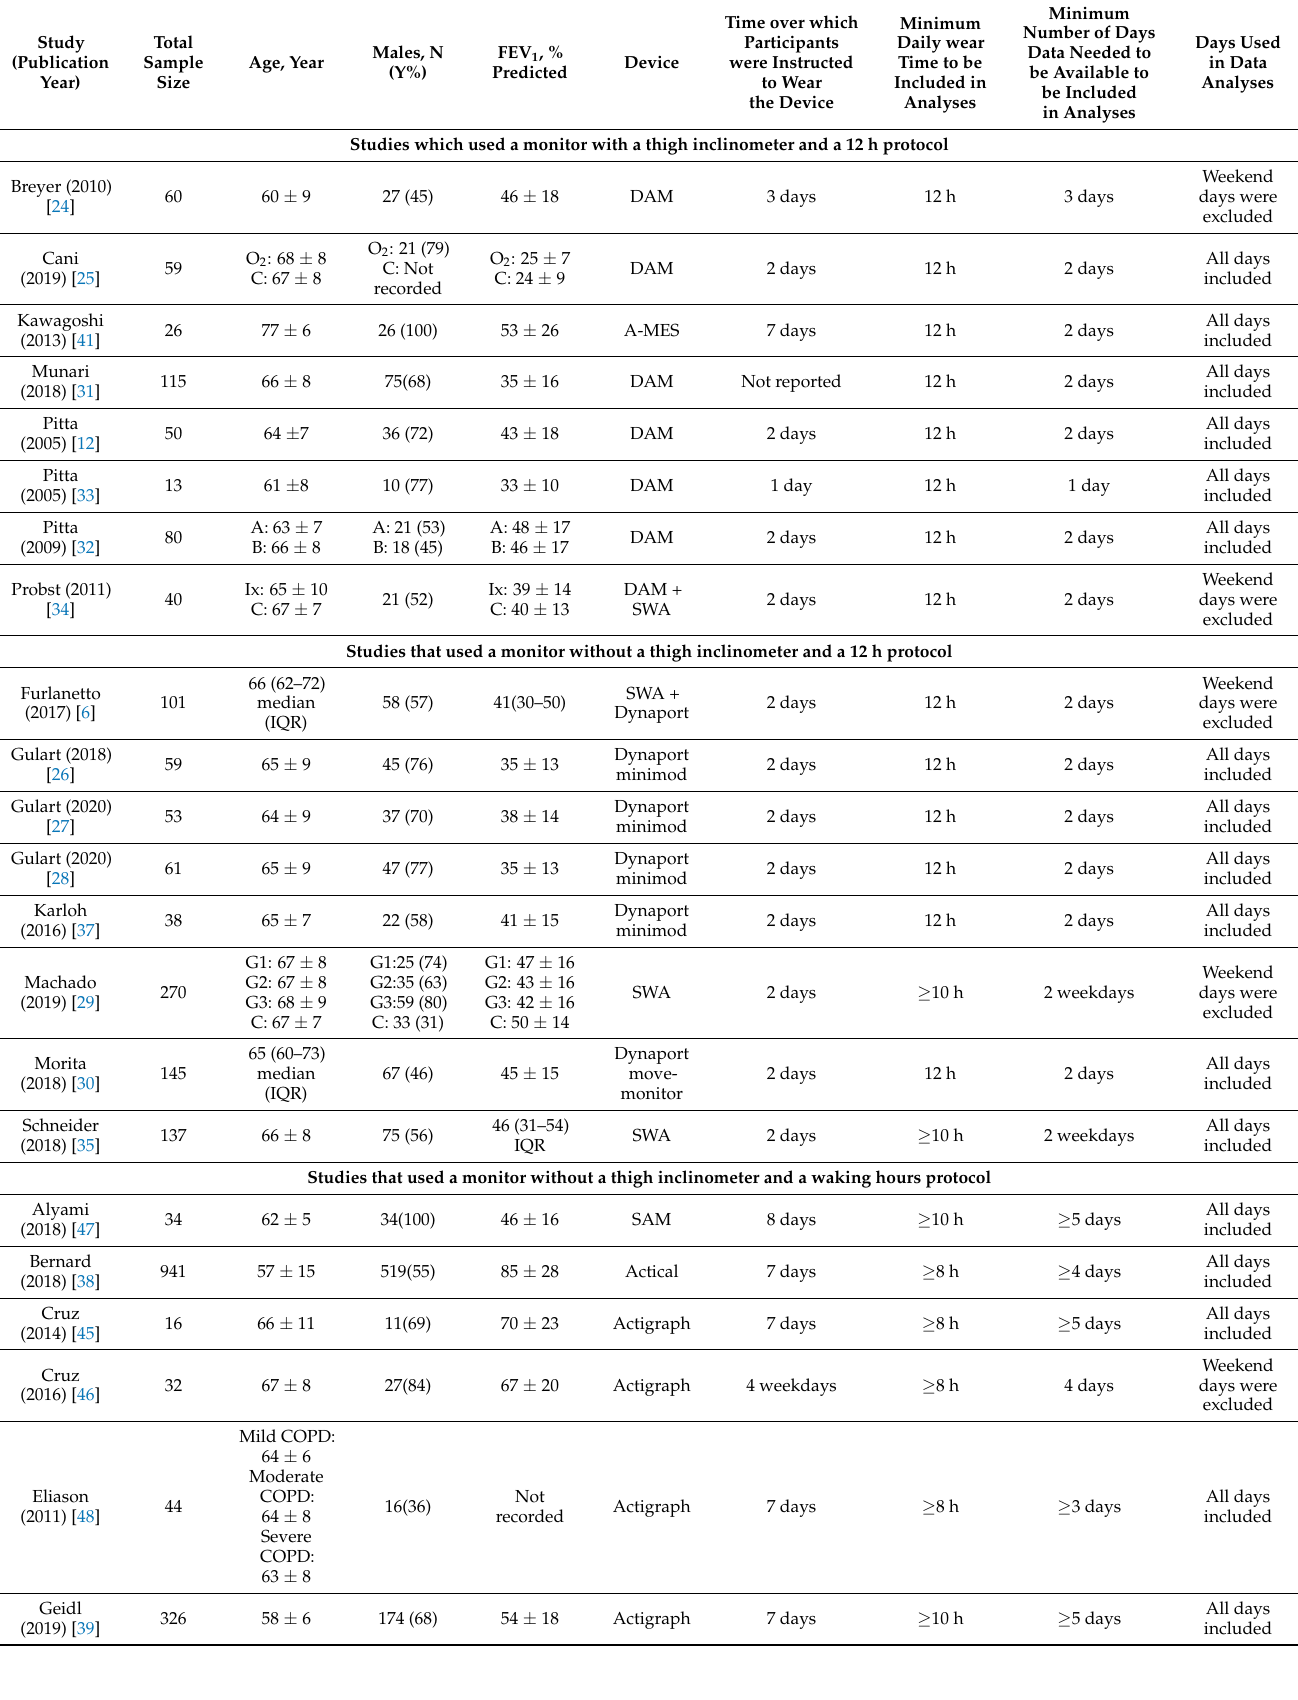
Table 1. Characteristics of included